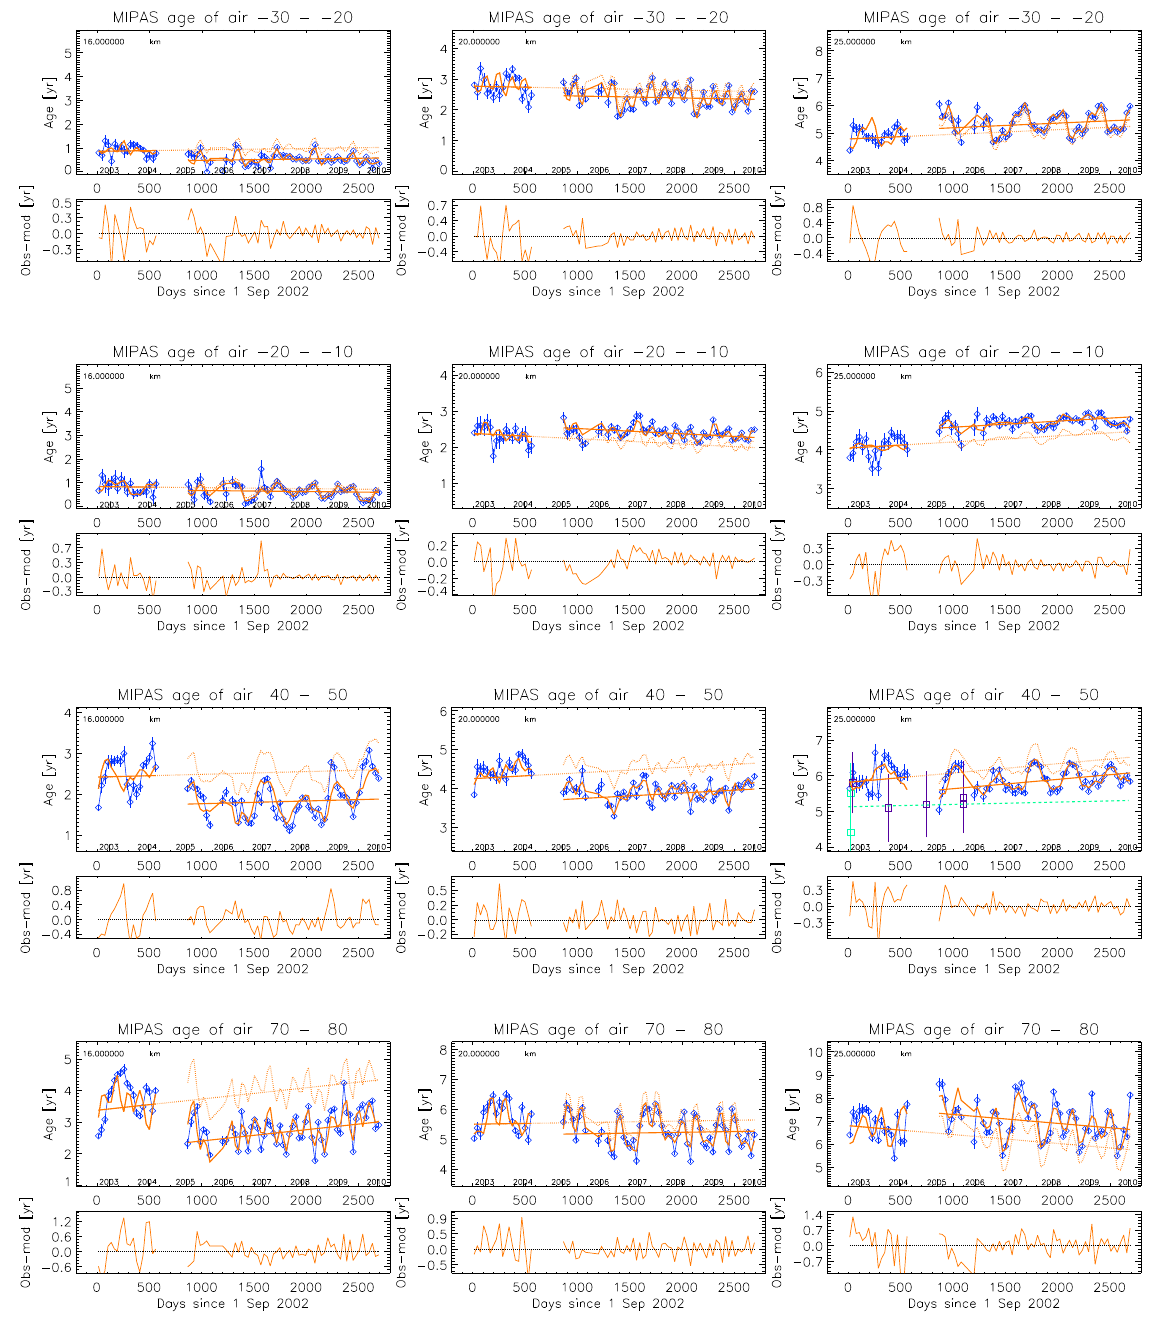
Fig. 6. Temporal evolution of age of air for the Southern subtropics (30 ◦ S to 20 ◦ S) (top row), tropics (20 ◦ S to 10 ◦ S) (second row), Northern mid-latitudes (40 ◦ N to 50 ◦ N) (third row), and Northern polar region (70 ◦ N to 80 ◦ N) (bottom row) at 3 different altitudes (16km, 20km, 25km). In the upper part of each panel, dark blue diamonds with error bars (the latter are often smaller than the diamonds and hardly visible) are the observed AoA monthly means and their SEM. The bold solid orange curve is the fit through the monthly mean data. The linear part of the regression is given as straight line. The dotted orange curve and straight line is the model without residual bias correction. In the panel for Northern mid-latitudes, 25km, the 30-yr AoA trend as derived by Engel et al. (2009) is included as a green dashed line, together with the data points and their uncertainties of the Engel et al. (2009) study which fall into the observation interval of MIPAS (green and violet squares, color coding of latitudes adapted to the original figure). In the lower part of each panel, the residuals between observed monthly mean AoA and the model are shown. 37